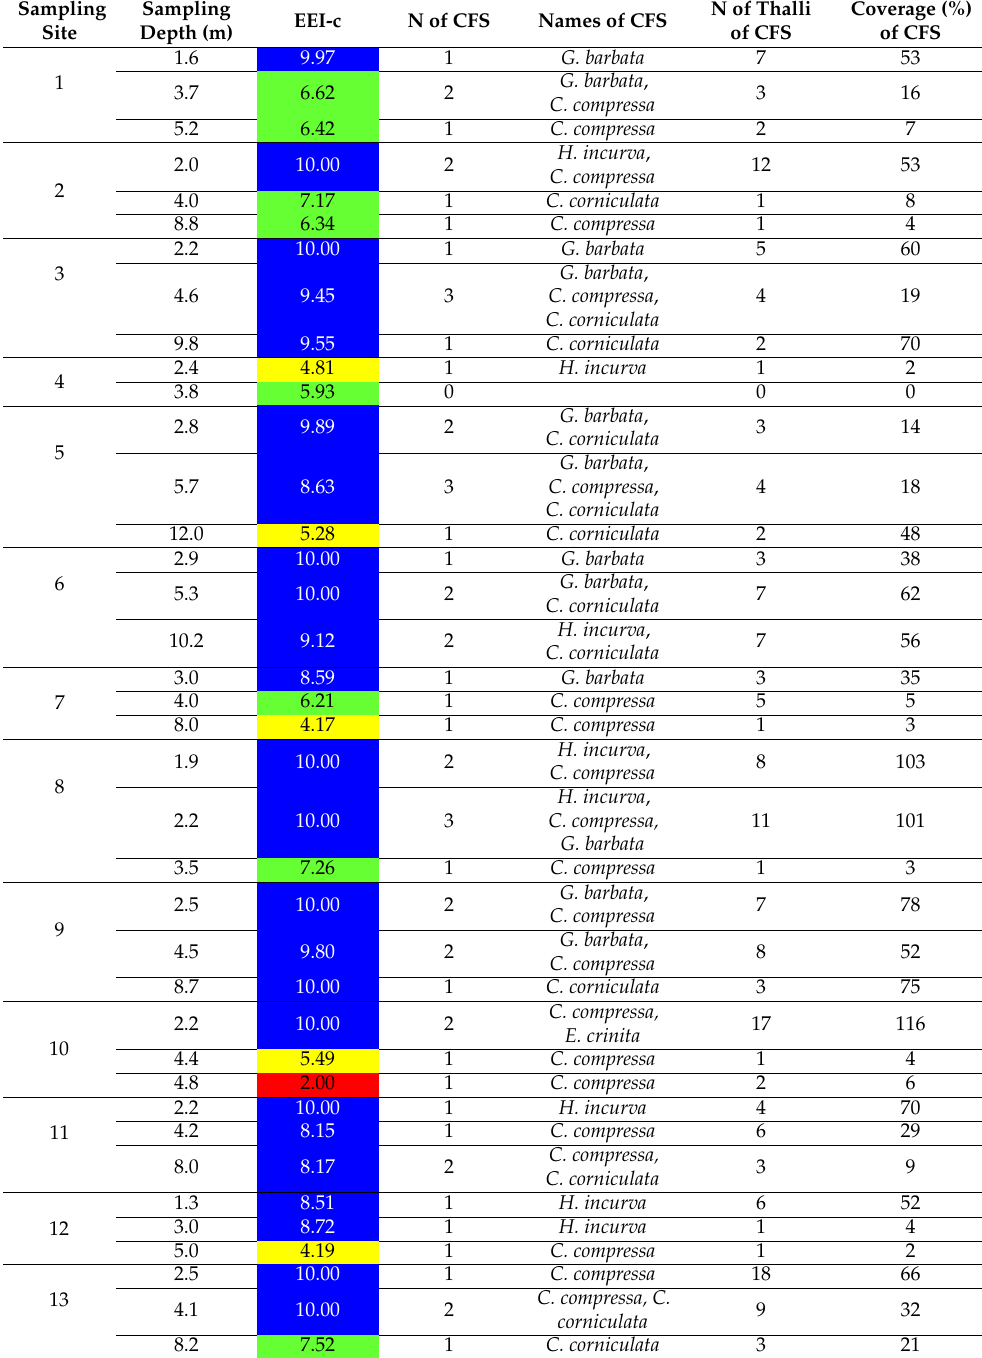
Table 2. Evaluation of the ecological status achieved by macroalgae at 3 different depths at 15 sampling sites, number and names of canopy-forming species (CFS), and number and cover- age (%) of thalli of CFS. Ecological status classes: high, in blue (10 ≥ EEI-c > 8.09), good, in green (8.09 ≥ EEI-c > 5.84), moderate, in yellow (5.84 ≥ EEI-c > 4.04), bad, in red (2.34 ≥ EEI-c). Sampling Sampling Site Depth (m)